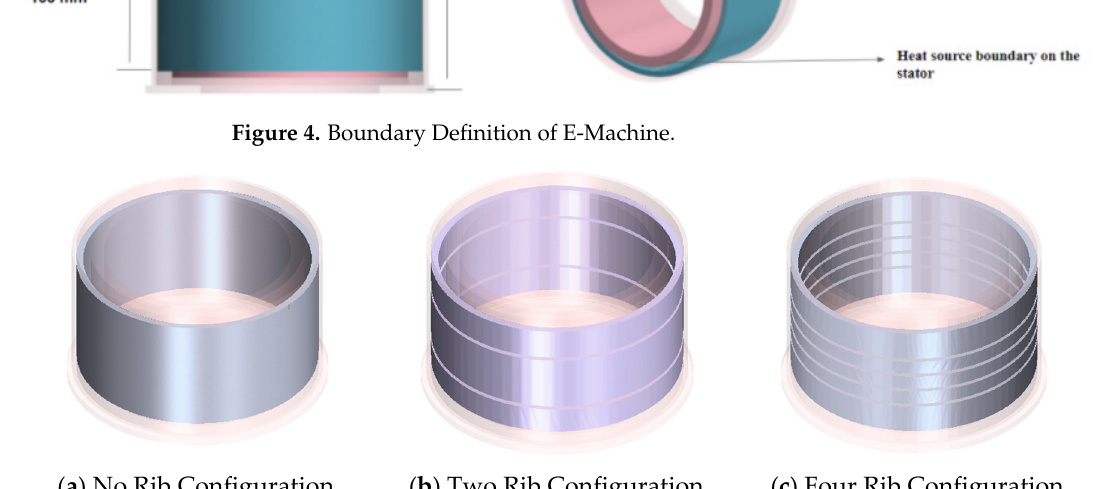
Figure 5. Different type of rib configurations used in the study.